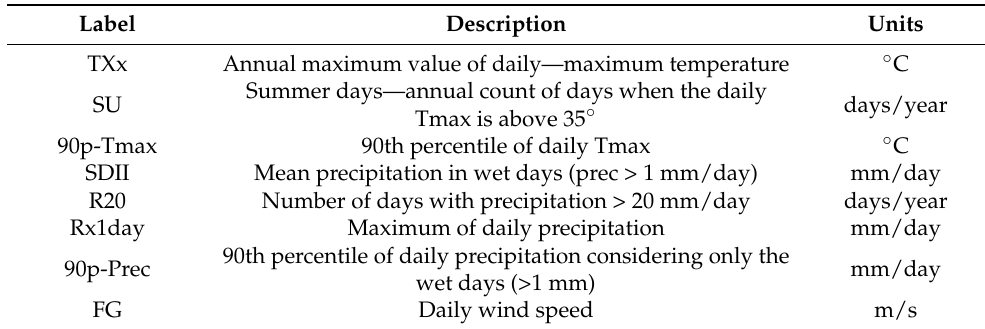
Table 2. Selection of Extreme Weather Events indicators based on Temperature/Precipitation/Wind considered in the present work.